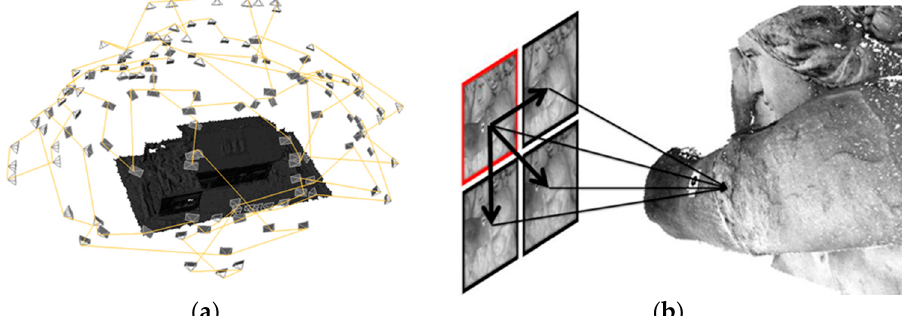
Figure 4. Dense reconstruction workflow among multiple views: ( a ) photogrammetric step; and ( b ) dense matching approach.